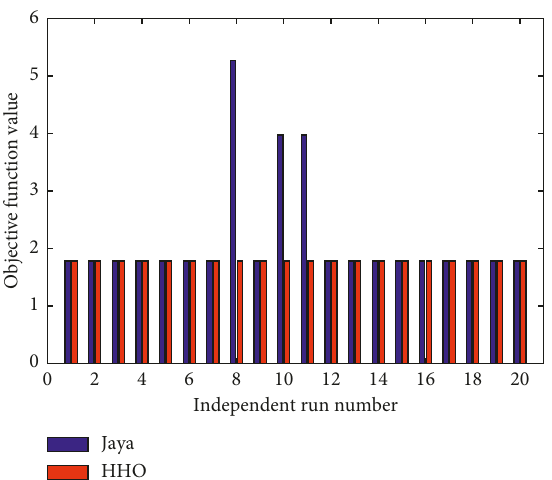
Figure 3: Independent runs for the 3-bus system by LP formulation.